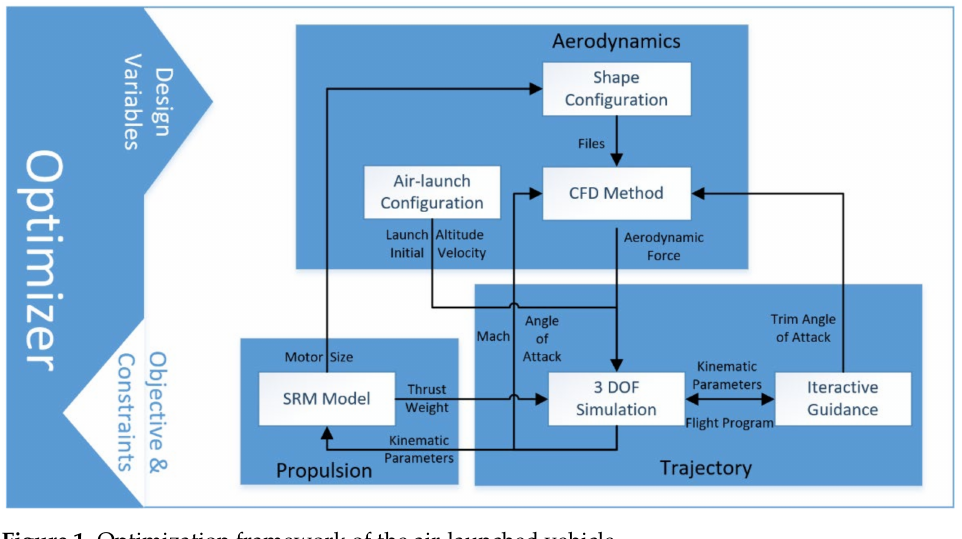
Figure 1. Optimization framework of the air-launched